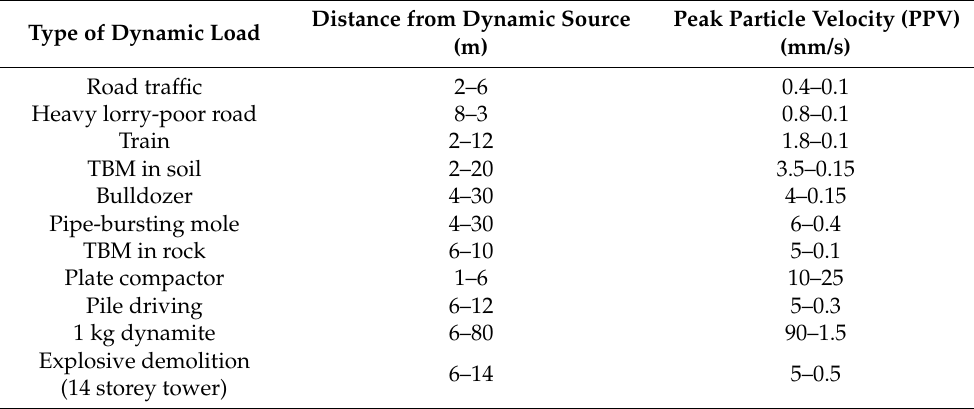
Table 1. Examples of anthropogenic vibrations